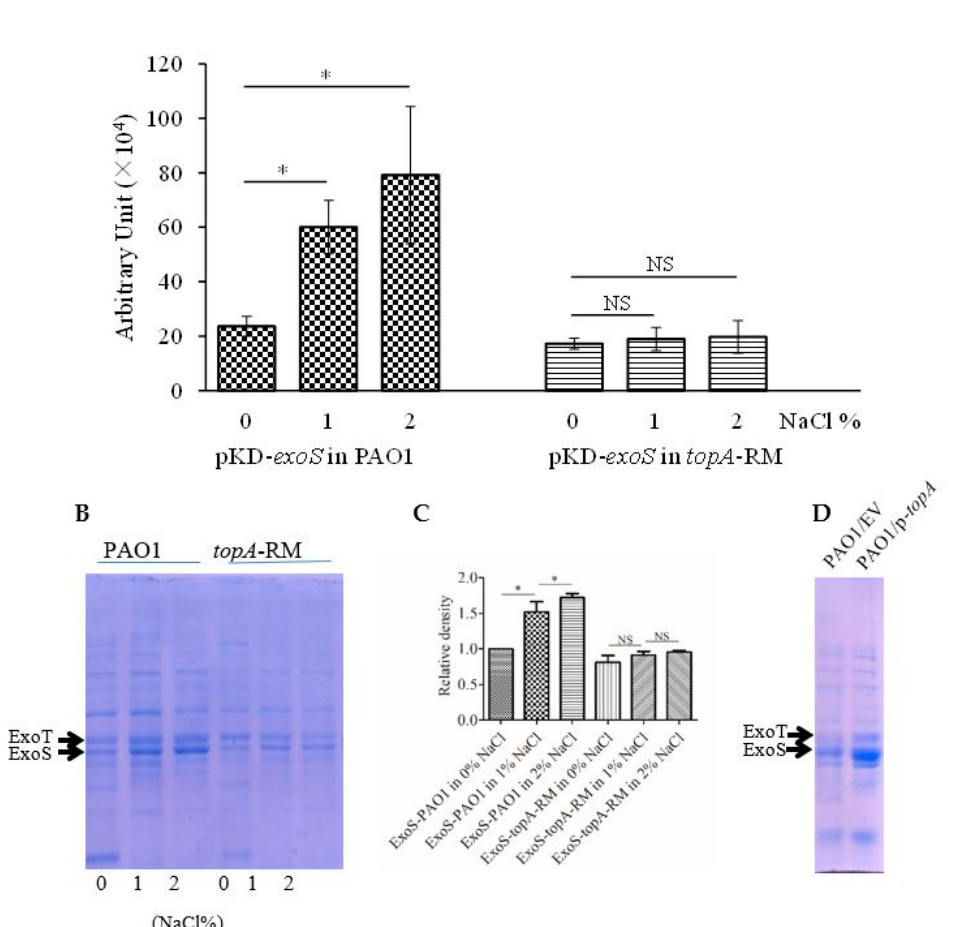
Figure 7. The correlation between T3SS effectors gene expression or effector secretion and the topoisomerase I, TopA. ( A ) The increased promoter activity of exoS with the increased concentration of NaCl in PAO1 but not in topA -RM. The reporter culture was serial diluted and spotted onto the plates with different concentrations of NaCl. After overnight incubation at 37 °C, light production of the reporter strain was recorded by a LAS-3000 imaging system (Fuji Corp.). The relative quantification of the promoter activities was evaluated by the software multi gauge version 3.0. The two-tailed unpaired t -test was used to analyze the data using GraphPad software version 5.0 (*, P < 0.05). NS: no significant difference. ( B ) Increased T3SS effectors protein secretion with elevated concentrations of NaCl in PAO1 but not in topA -RM. ( C ) Quantification of ExoS treated under different concentrations of NaCl. (D) Overexpression of topA on pUCP26 resulted in elevated T3SS effectors secretion. ExoT and ExoS bands are indicated by solid arrows, as established in previous reports [28,31]. EV: Empty vector as a control; p- topA: topA complementation construct. The results shown are representatives of three independent experiments with similar results.